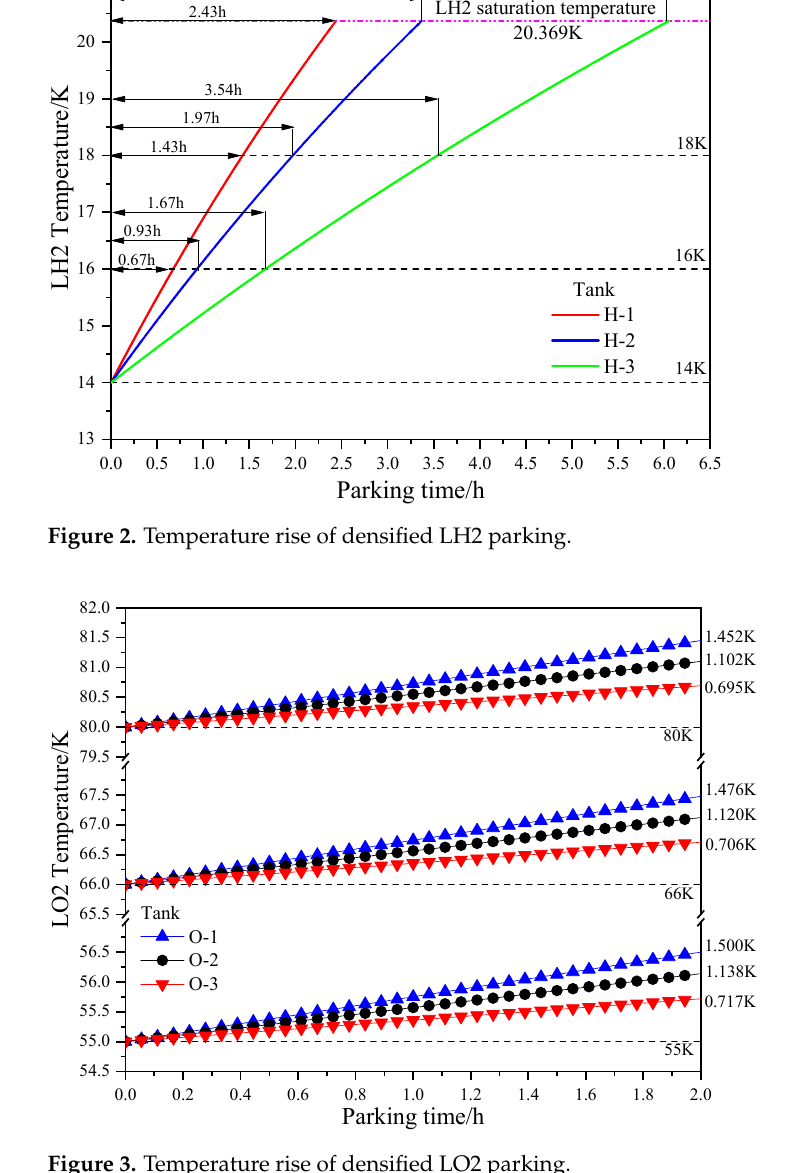
Figure 2. Temperature rise of densified LH2 parking.